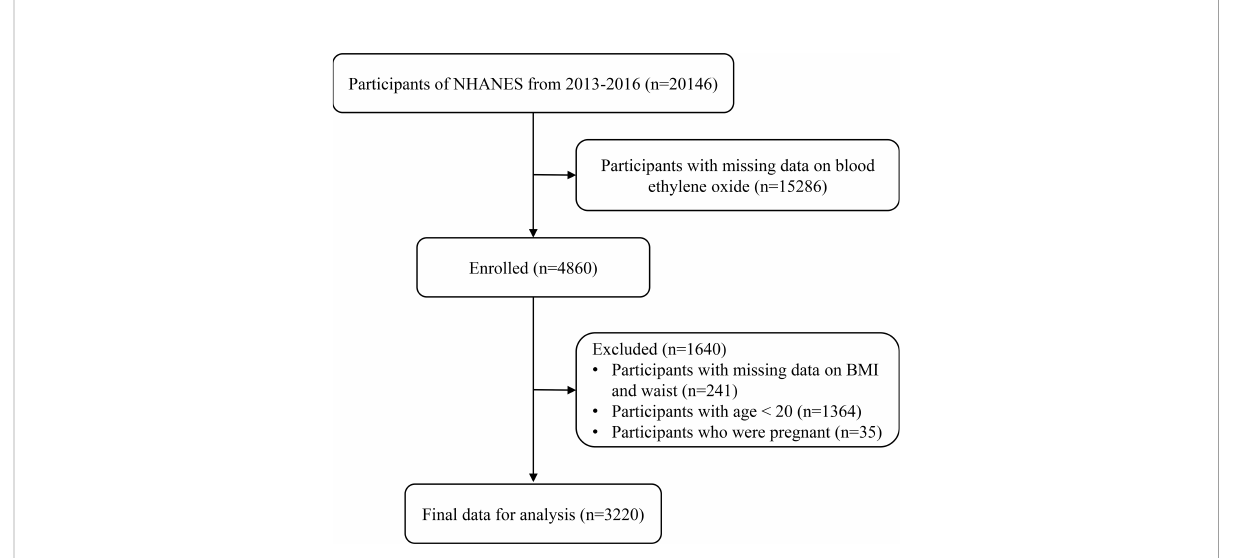
FIGURE 1 Study population fl owchart. NHANES, National Health and Nutrition Examination Survey; BMI, body mass